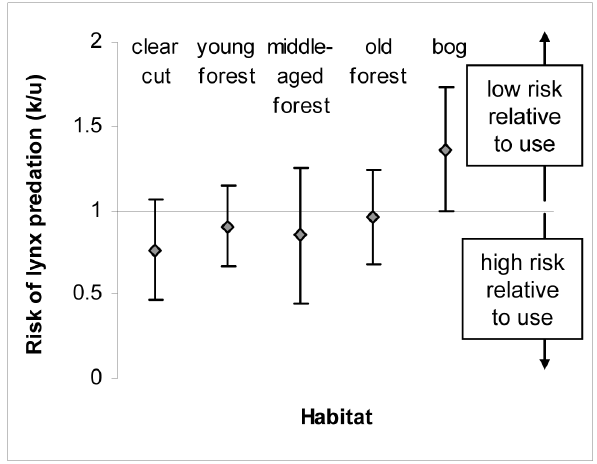
Figure 2. Habitat-specific risk of lynx predation (mean ± 95% CI) at the spatial and temporal scales of home-ranges and seasons at Grimsö Wildlife Research Area in 1997-2007. Neutral risk of predation is equal to one (i.e. a line following the